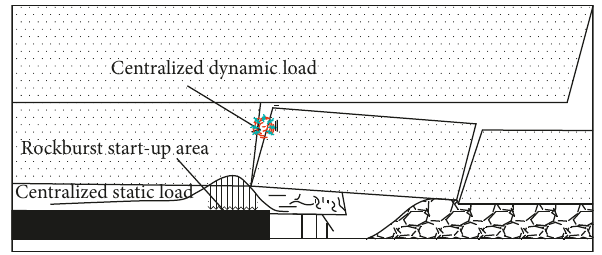
Figure 3: Engineering structure model of concentrated dynamic- type